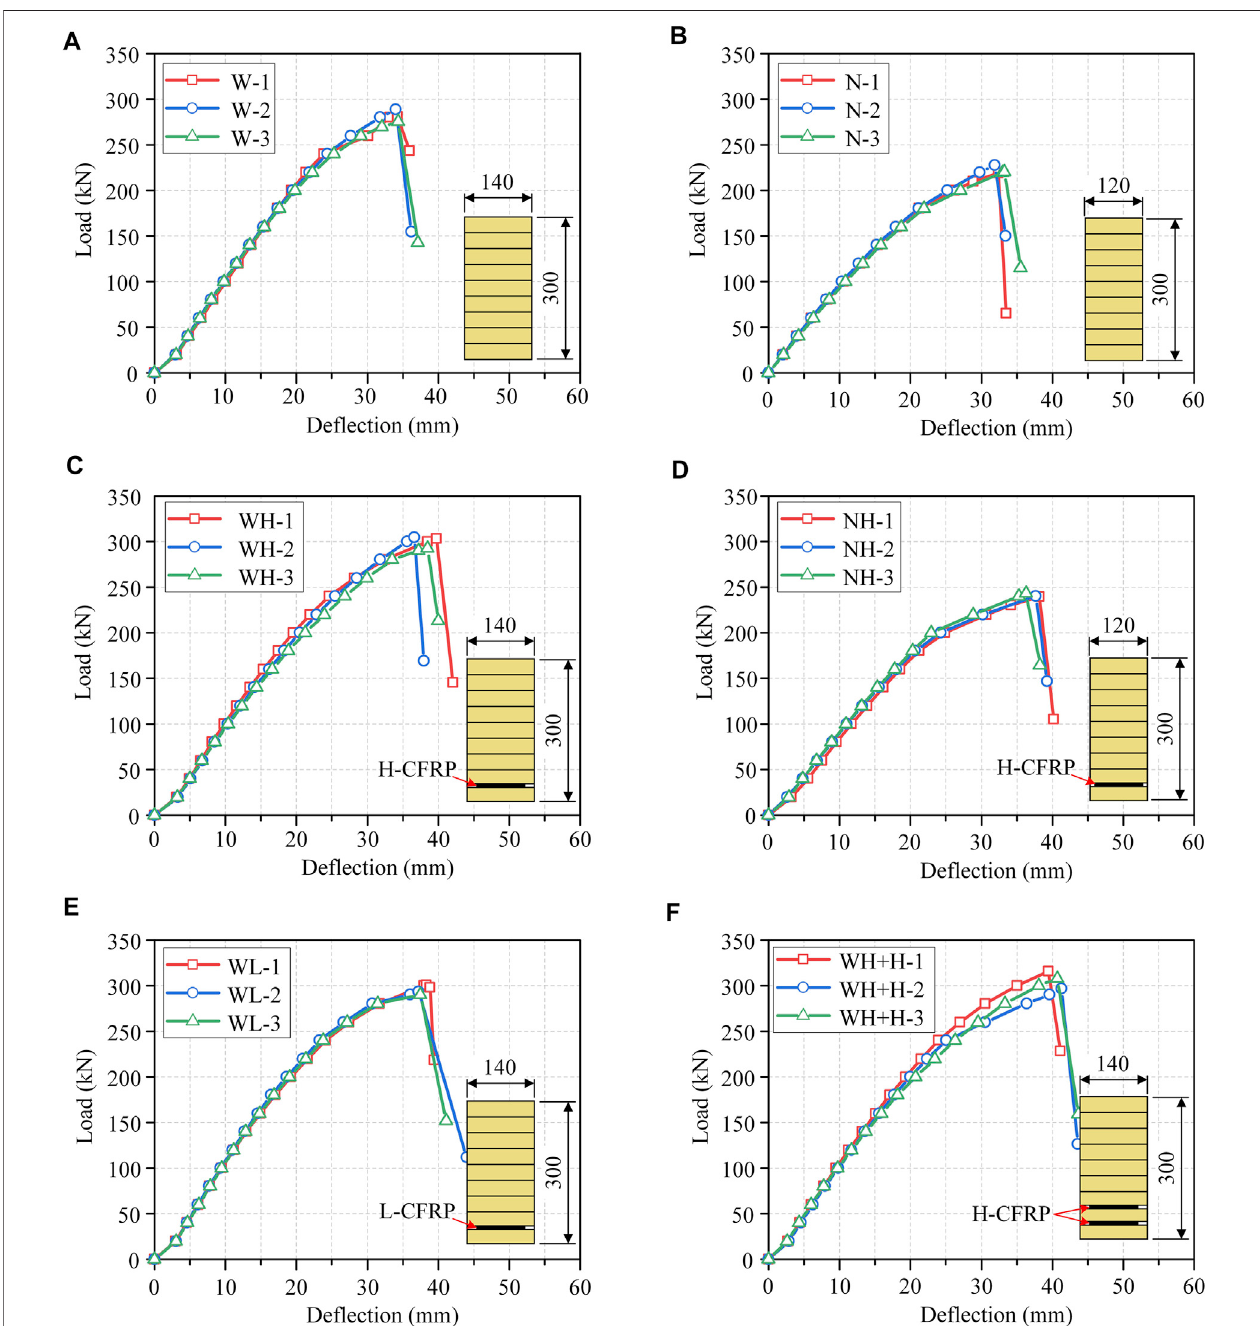
FIGURE 5 | Load – de fl ection curves: (A) group W; (B) group N; (C) group WH; (D) group NH; (E) group WL; and (F) group